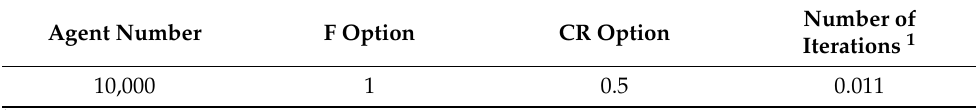
Table 2. First Step Differential Evolution algorithm